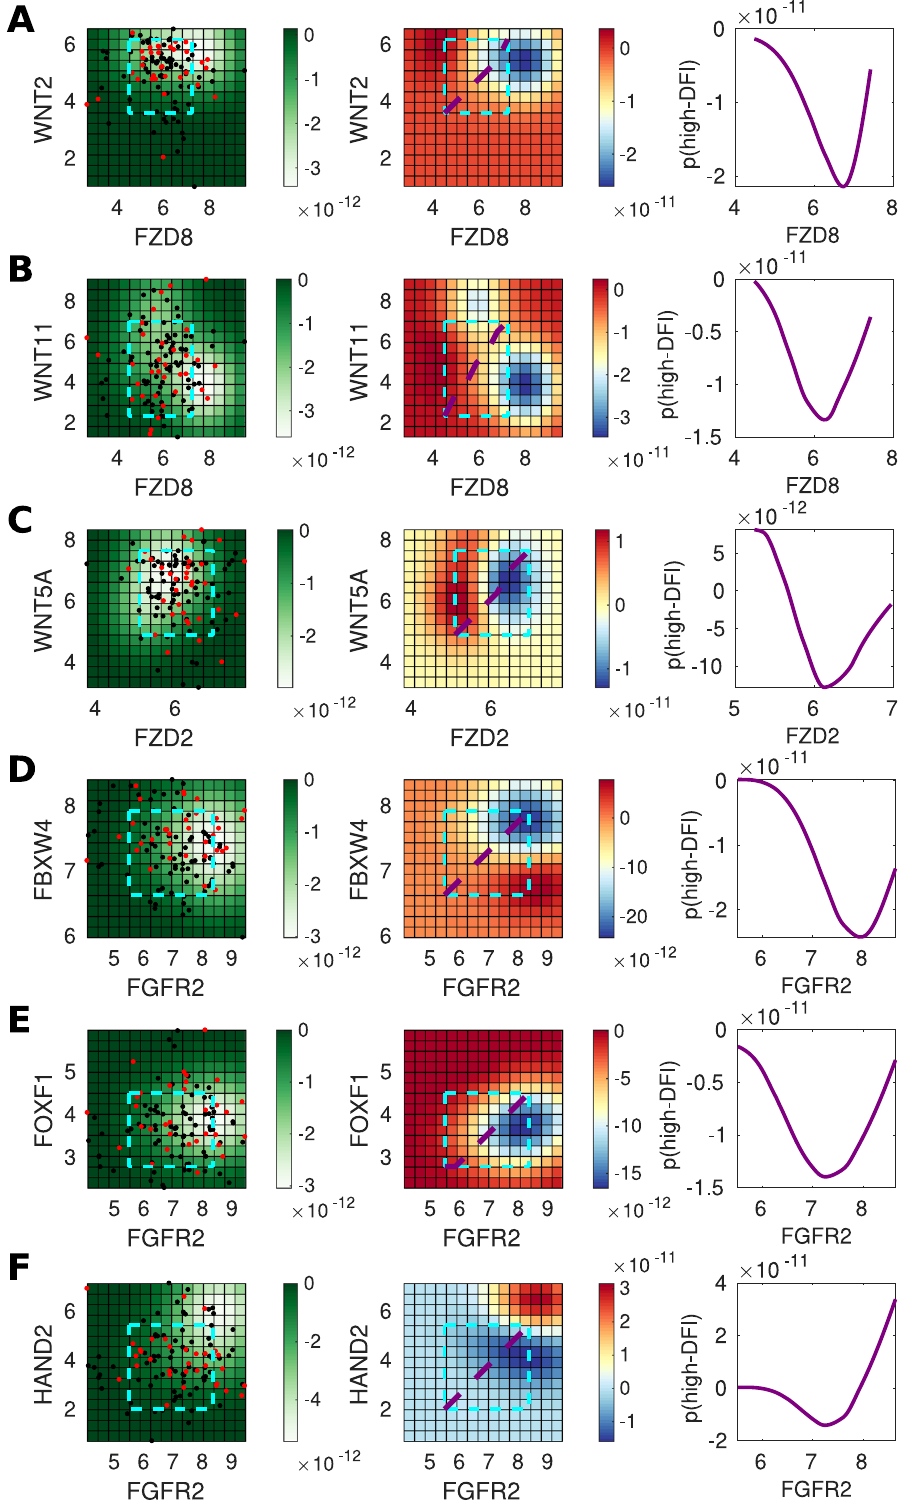
Fig. 6 Genes predictive of invasiveness in UCEC. A For gene pair WNT2 and FZD8 , the left panel shows the posterior variance on log – log expression plot of the predicted probability overlaid with patient samples (red = low-DFI, black = high-DFI), 90% con fi dence interval box drawn for standardized expression values (cyan); middle panel: posterior log probability of high-DFI over the same region as left, where the diagonal line (purple) shows the co- expression trend (diagonal line through the 90% CI of standardized expression values); right panel: posterior log probability of high-DFI plotted against the expression of FZD8 , values simulated along the diagonal (purple) corresponding to the middle panel. B As above for WNT11 and FZD8 . C As above for WNT5A and FZD2 . D As above for FBXW4 and FGFR2 . E As above for FOXF1 and FGFR2 . F As above for HAND2 and FGFR2